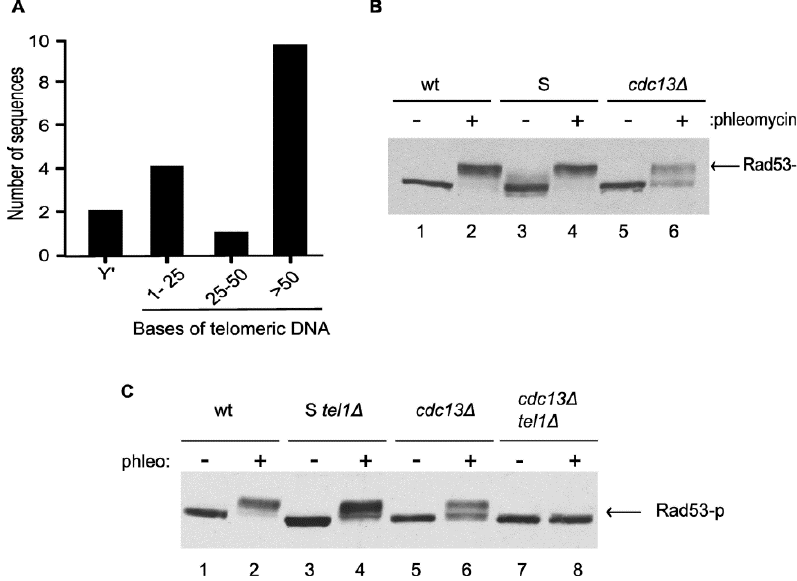
FIGURE 1: Mec1-dependent Rad53 phos- phorylation is defective in cdc13 Δ cells. (A) Terminal chromosomal regions were ampli- fied by PCR and sequenced. Telomeric DNA (in bases) present on the amplified frag- ments is indicated. A total of 17 independ- ent sequences were obtained, with two of them ending in the subtelomeric Y’ ele- ment. (B) Exponentially growing wild-type (wt), Survivor (S) or cdc13 Δ ( cdc13 Δ) cells were left untreated or were treated with phleomycin for 2 h. Protein extracts were prepared and analyzed by western blotting with an anti-Rad53 antibody. (C) As in (B) except that cells also lacked the TEL1 gene as indicated in the Survivors (S) and Cdc13- independent ( cdc13 Δ) cells. Cells were left untreated or were treated with phleomycin for 2